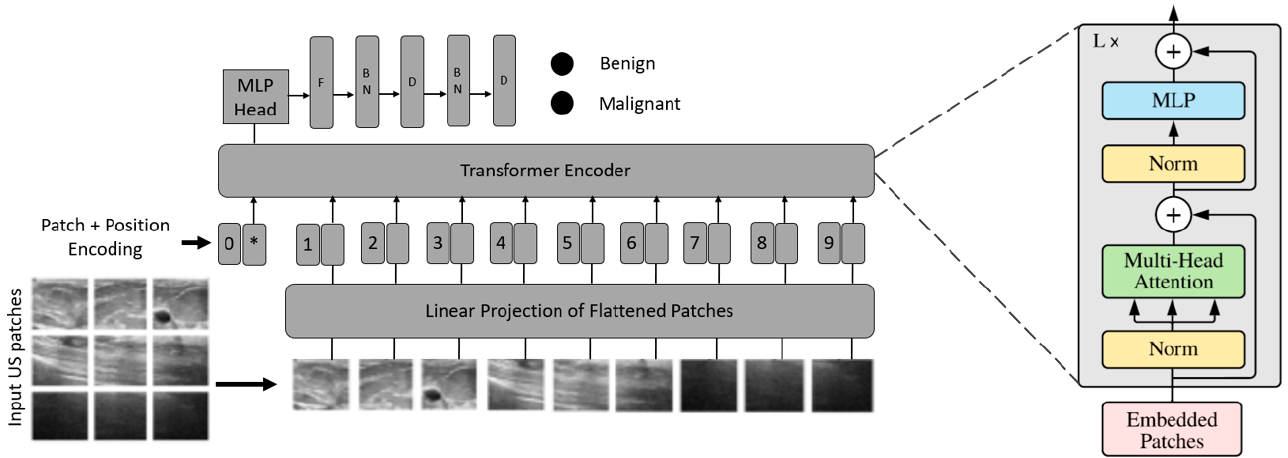
Figure 6. The proposed vision transformer-based transfer-learning model. US, ultrasound; MLP, multilayer perceptron; F, flatten; BN, batch normalization; D, dense layer. multilayer perceptron; F, flatten; BN, batch normalization; D, dense